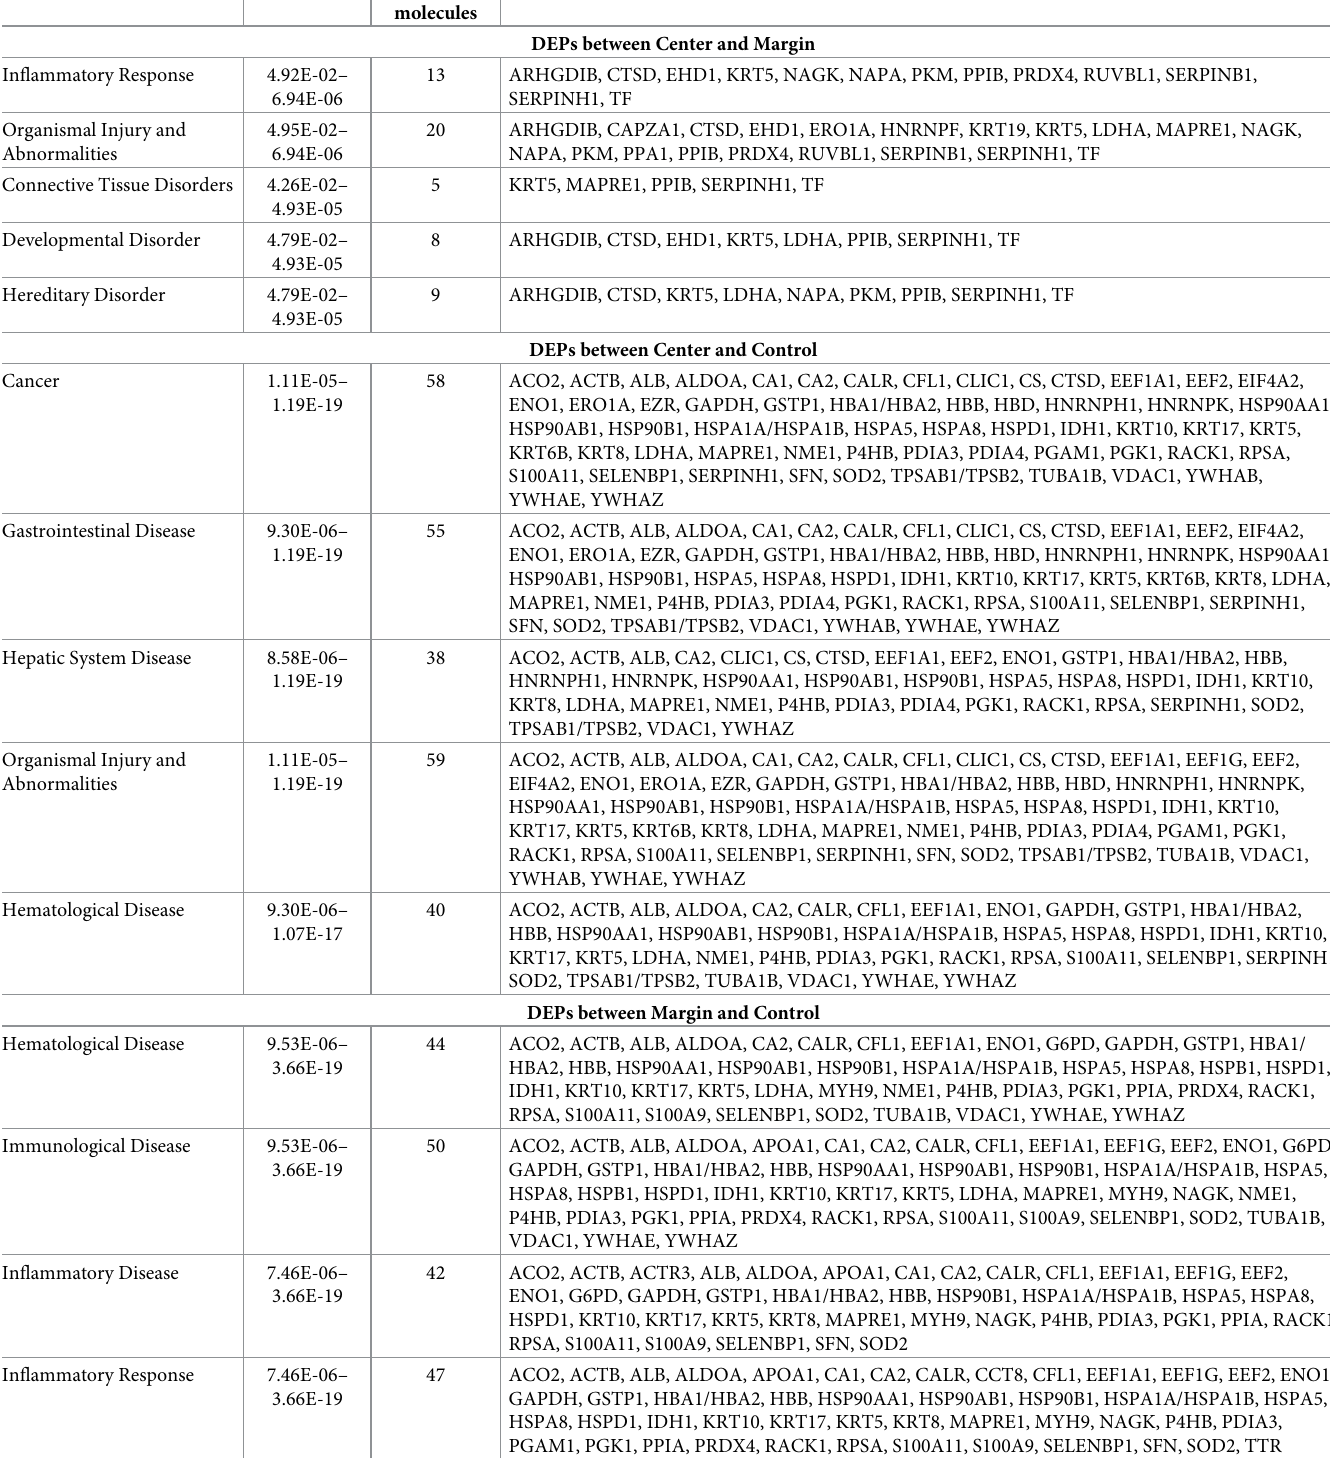
Table 4. Top disease and disorder of differentially expressed proteins (DEPs) in SCC